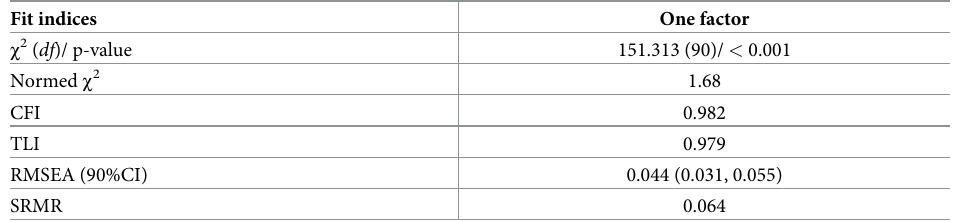
Table 2. Confirmatory factor analysis (CFA)